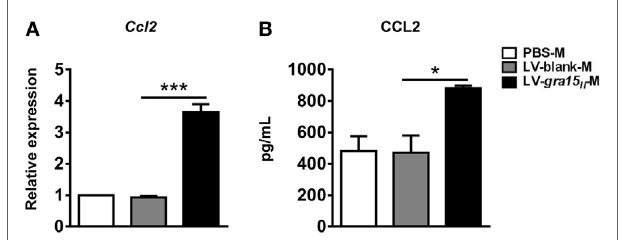
FigUre 3 | Lentiviral vector- gra15 II -M increased the expression of C-C motif chemokine ligand 2 (CCL2). The liver macrophage RNA was extracted and the expression of CCL2 was analyzed by qRT-PCR (a) . Culture supernatants of the liver macrophages were collected and assayed for the secretion of CCL2 by enzyme-linked immunosorbent assay (B) . Data represent mean ± SD from multi-group experiments. * p < 0.05 and *** p < 0.001 ( n = 4 each